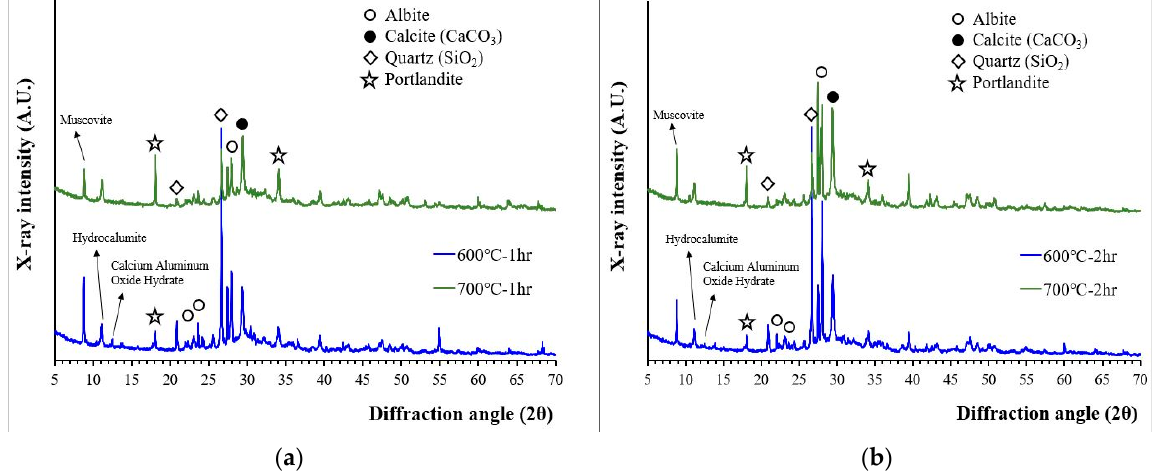
Figure 4. XRD patterns of wasteform specimens made of a 1 M CsCl solution and recycled cement powder that was heat treated at 600 and 700 °C: ( a ) for 1 h; and ( b ) for 2 h.